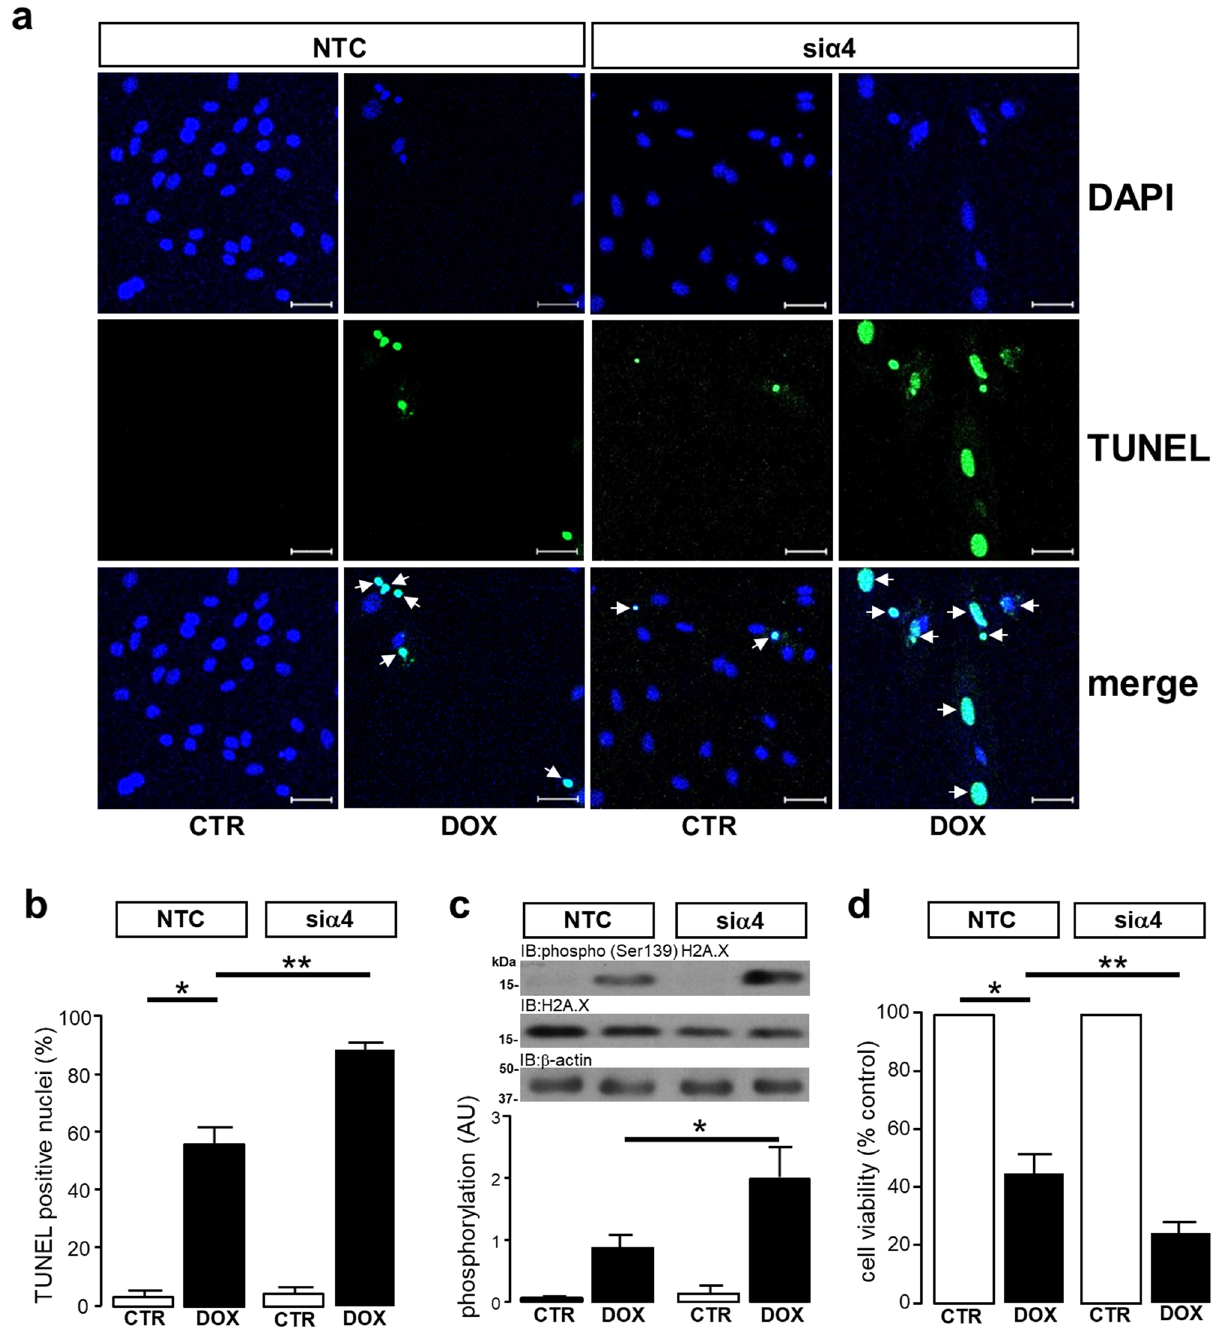
Figure 3. Alpha4 protein regulates doxorubicin-induced DNA damage and cytotoxicity in cardiomyocytes. H9c2 cardiomyocytes were transfected with either 50 nM non-targeting control (NTC) siRNA or 50 nM siRNA specific to rat α4 protein (siα4) for 4 days. H9c2 cardiomyocytes were exposed to either DMEM vehicle control (CTR) or 1 µM doxorubicin (DOX) for 24 h on day 3. DNA fragmentation in H9c2 cardiomyocytes imaged at × 100 magnification was determined by TUNEL assay. Nuclei were stained with DAPI and samples were excited at 405 nm, whereas DNA fragmentation in samples was determined by fluorescein-conjugated TUNEL and excited at 488 nm. White arrows in merged images indicate positive TUNEL stained nuclei, n = 3, scale bar = 50 µm ( a ). DNA damage was quantified by counting DAPI stained nuclei followed by the number of TUNEL positive nuclei in 5 randomly selected regions of interest within the field of view, n = 3 ( b ). H9c2 cardiomyocytes were transfected with either 50 nM non-targeting control (NTC) siRNA or 50 nM siRNA specific to rat α4 protein (siα4) for 4 days. H9c2 cardiomyocytes were exposed to either DMEM vehicle control (CTR) or 100 nM doxorubicin (DOX) for 24 h on day 3. Phosphorylation of H2AX at Ser139 was then determined by Western analysis using a phosphospecific antibody raised against residues surrounding Ser139 of human H2AX, n = 4 ( c ) and cell viability was determined by MTT assay, n = 3 ( d ). All data represents mean values ± SEM and statistical significance was determined by ANOVA followed by a multiple comparison Tukey’s modified test. Expression of β-actin was used to confirm equal protein loading between